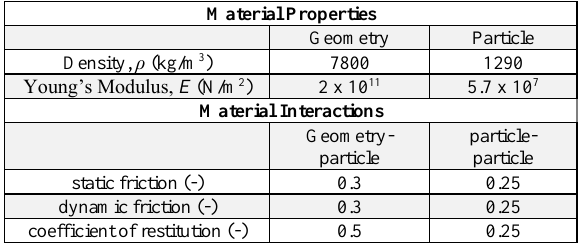
Fig. 1. PicoPlex pin mill of Hosokawa Micron comprising a stationary and a rotating part (a); particle modelled as 26 faces polyhedron (b) and simplified geometry of pin mill (c). Table 1. Material properties and interactions.